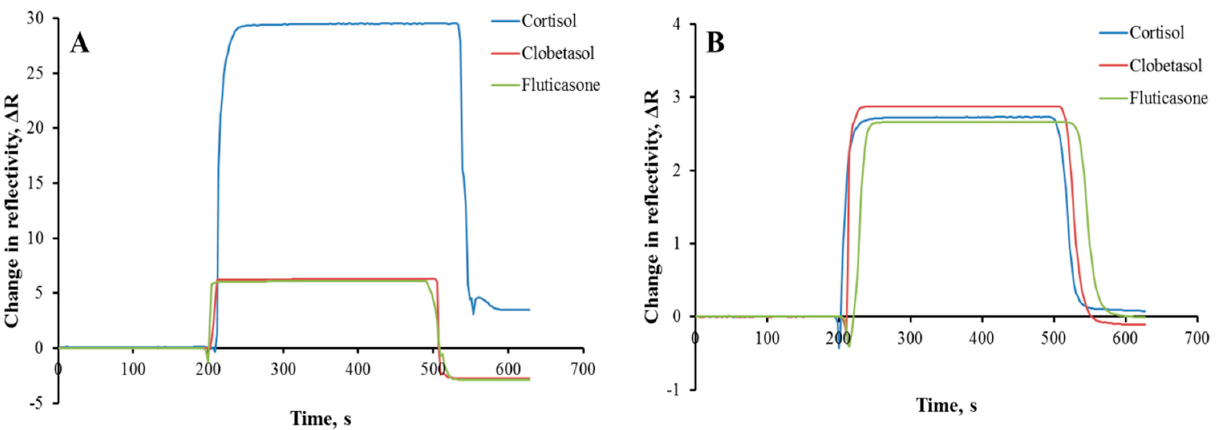
Figure 5. Selectivity sensorgrams of AuNP-MIP ( A ) and AuNP-NIP ( B ) plasmonic sensors. Cortisol concentration: 100 ppb; adsorption solution: PBS-ethyl alcohol (50:50, v / v ); interaction time: 10 min; flow rate: 0.2 mL/min; T: 25 °C.